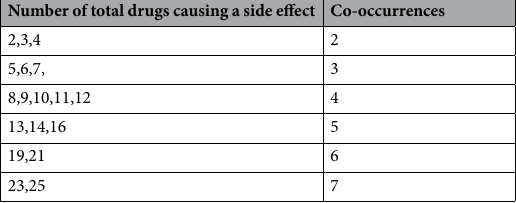
Table 1. SE-related gene sets threshold.